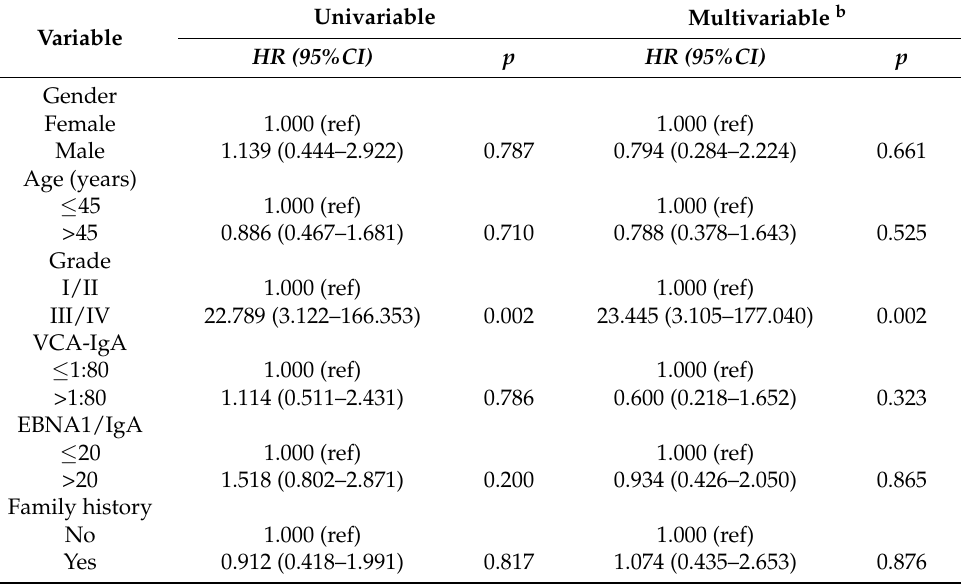
Figure 1. The association of serum adiponectin levels with survival in NPC patients. Kaplan–Meier curves were used to illustrate several patients. ( A ) Overall survival and ( B ) metastasis-free survival were analyzed according to serum adiponectin levels based on a cutoff of 8.00 µ g/mL in NPC patients ( n = 106). p -values were determined by the log-rank test. Table 2. Univariable and multivariable Cox regression analyses of potential factors for the metastasis- free survival in NPC patients a